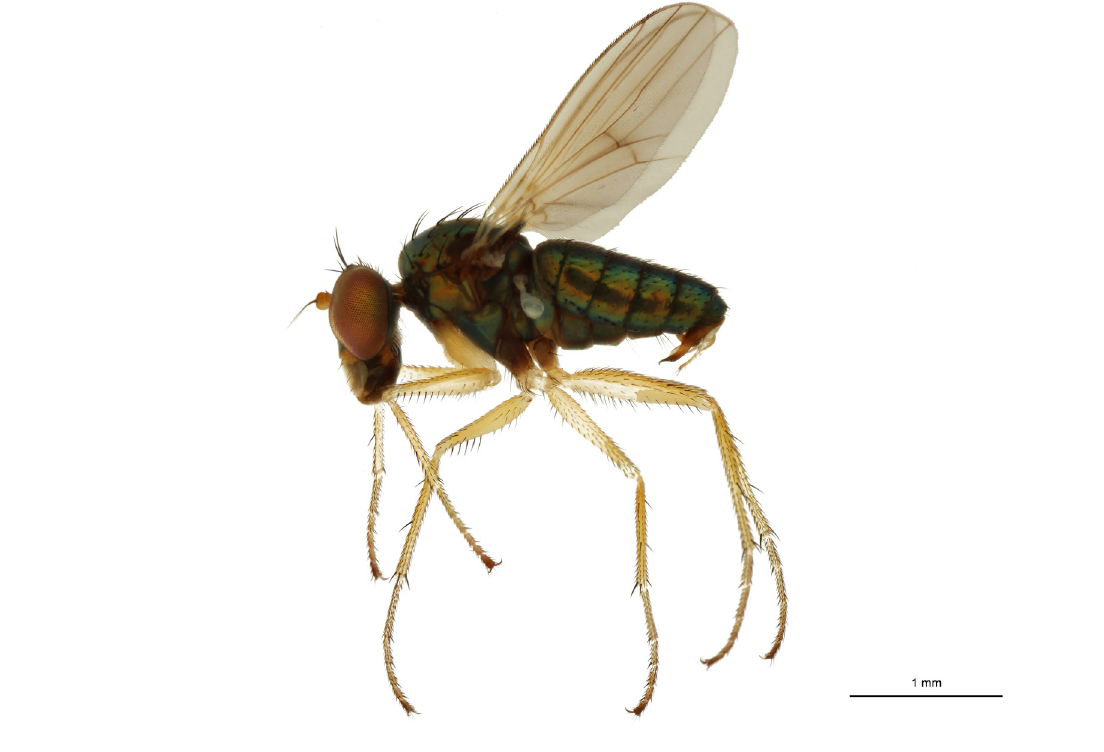
Fig. 2. Thinophilus inaequalis Samoh & Grootaert sp. nov. Male habitus (Abdulloh Samoh leg., PSUNHM